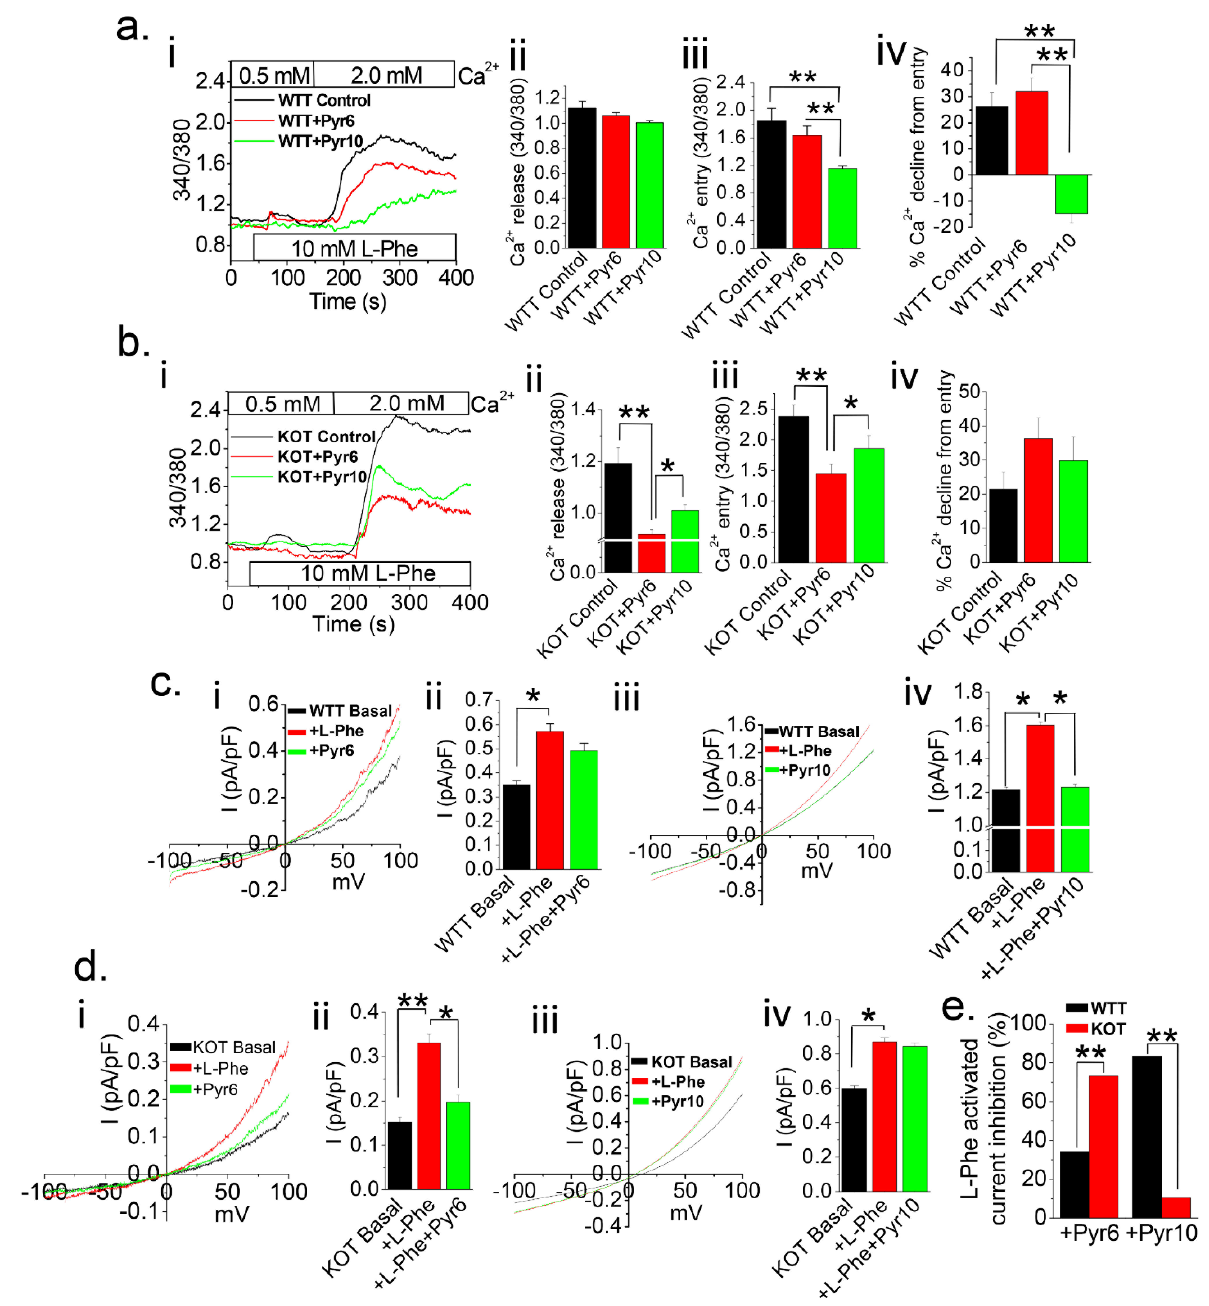
Figure 2. Ca 2+ entry pathway in PT cells is contingent upon presence of TRPC3 in higher PT luminal pH conditions. Ratiometric [Ca 2+ ] i measurements were performed and plotted on Fura-2 loaded PT cells from Acz treated mice ( a ) WT (WTT) and ( b ) KO (KOT) PT cells with no inhibitors (WTT Control or KOT Control), Pyr6 (3 μM), or Pyr10 (3 μM). Prior to experiments, PT cells were placed in a 0.5 mM Ca 2+ bath and L-Phenylalanine (L-Phe; 10 mM) was applied. Subsequently, 2 mM Ca 2+ was applied to replenish [Ca 2+ ] o . ( aii , bii ) Peak Ca 2+ release , ( aiii , biii ) Peak Ca 2+ entry, and ( aiv ) Percent Ca 2+ decline from entry were quantified into bar diagrams in means ± SEM. ( c , d ) Single cell patch clamp voltage sweeps from −100 to +100 mV were performed on WTT or KOT PT cell. L-Phe (10 mM) was applied to induce current and ( ci , cii , di , dii ) Pyr6 (3 μM) or ( ciii , civ , diii , div ) Pyr10 (3 μM) was applied as a current blocker. ( cii , civ , dii , div , e ) Average current density at +100 mV and L-Phe activated current inhibition percentage were quantitated into means ± SEM, respectively. Experiments were performed four times. *, p < 0.05; **, p < 0.01.